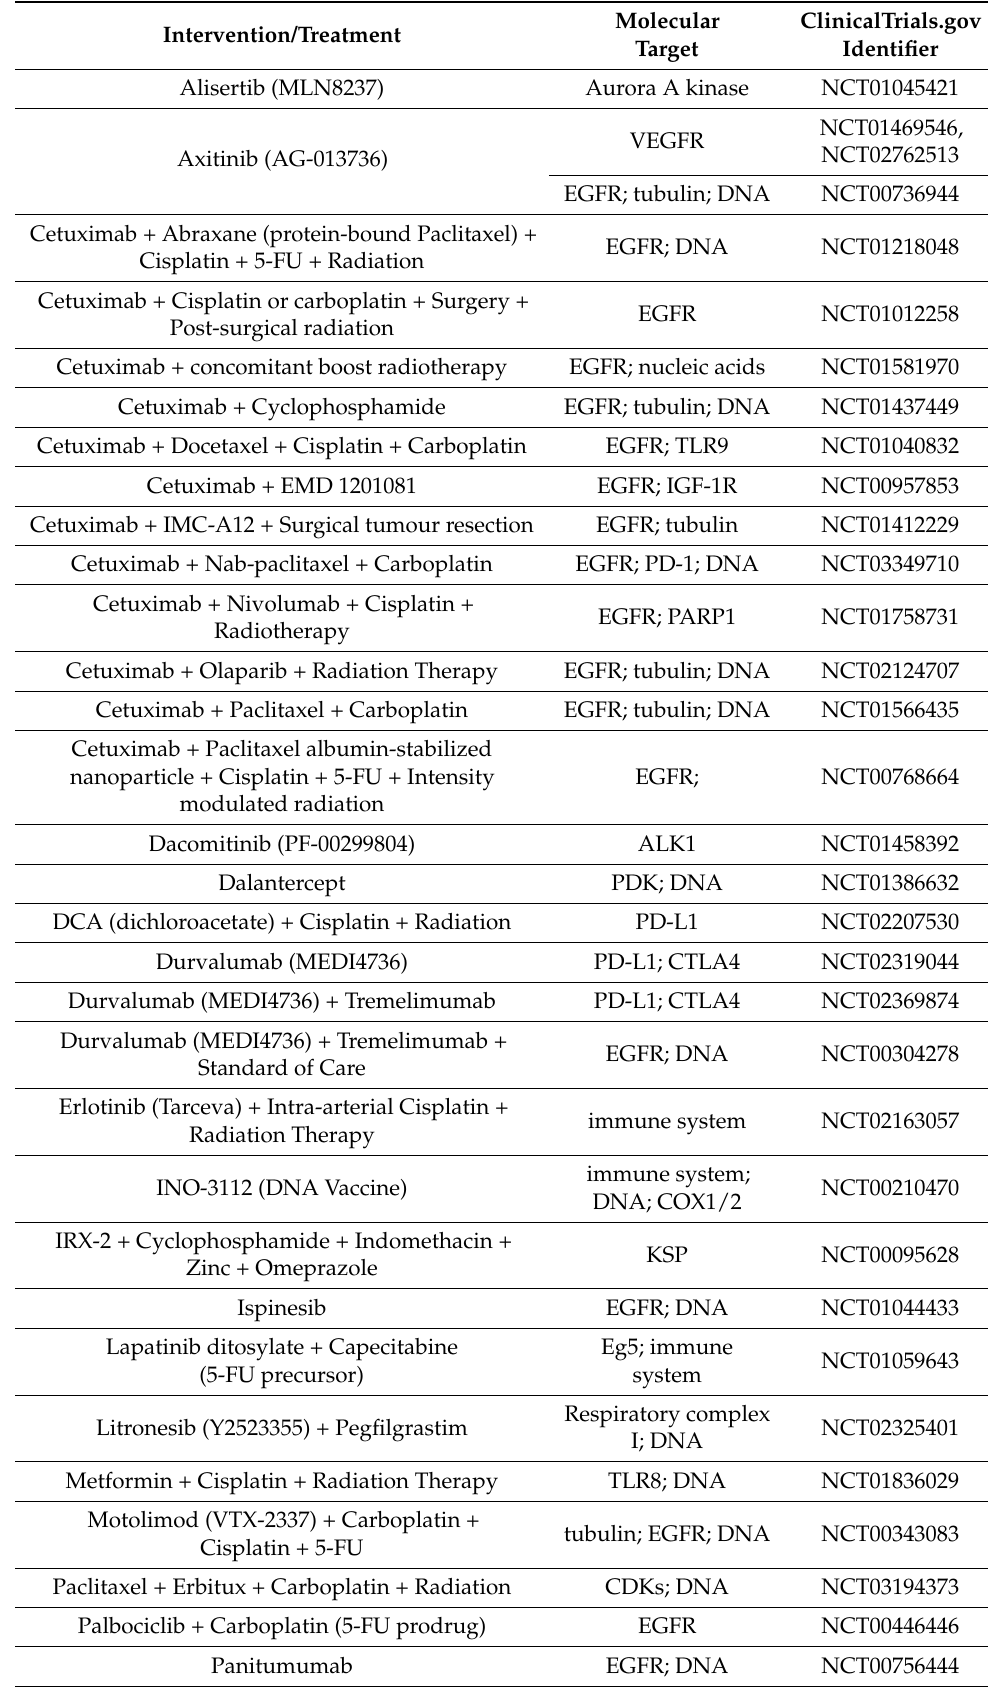
Table 1. Ongoing or recently completed clinical trials in HNSCC exploring experimental